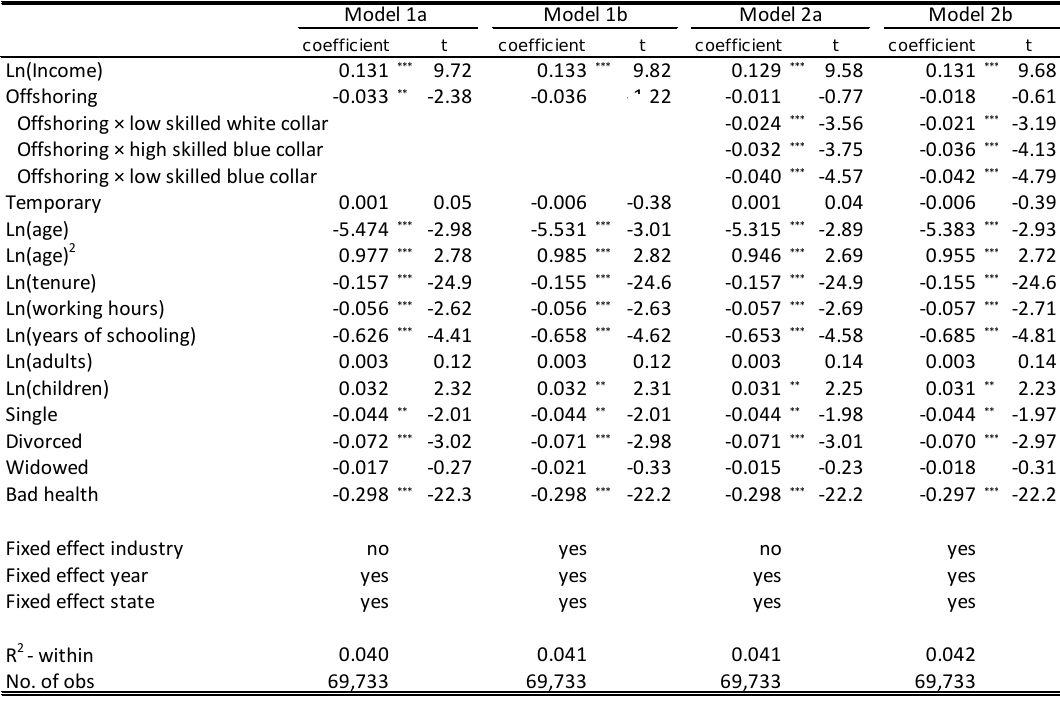
Table 2. Job Satisfaction and